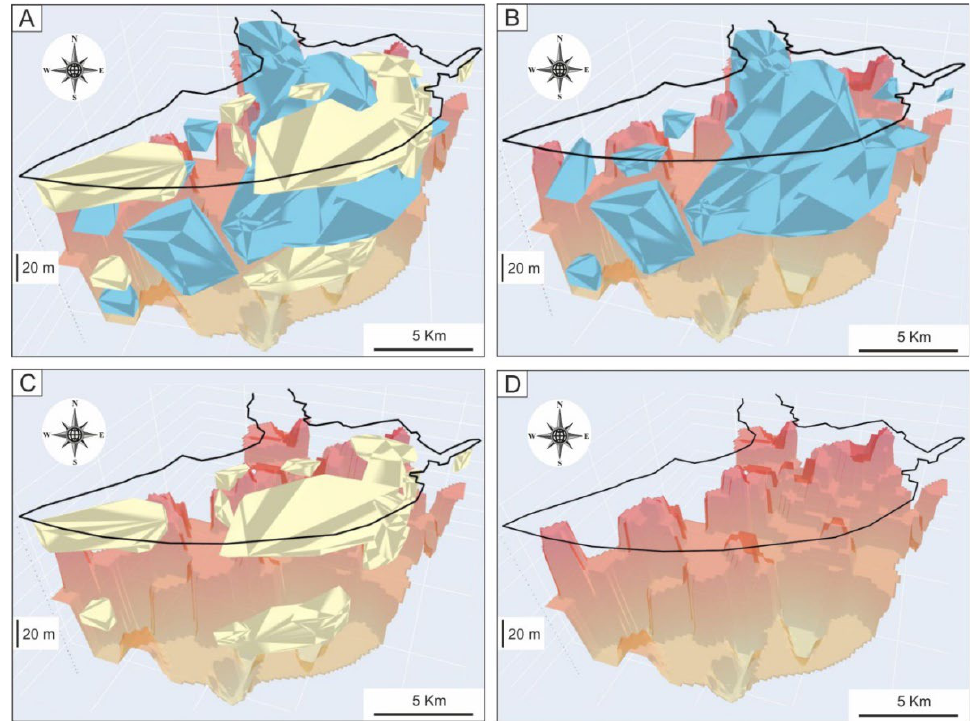
Figure 6. The 3D stratigraphic architecture (coarse lithosomes and the basement top surface (BTS)) of the onshore LRD. ( A ) Gravel and coarse sand lithosomes and BTS. ( B ) Gravel lithosomes and BTS. ( C ) Coarse sand lithosomes and BTS. ( D ) Basement top surface. The color assigned to each granulometry class is cyan for gravel, yellow for coarse sand, and reddish-brownish for the base- ment. An interactive 3D HTML version of this model is included in Supplementary Materials (3D_Lithosomes_LRD.html (accessed on 12 July